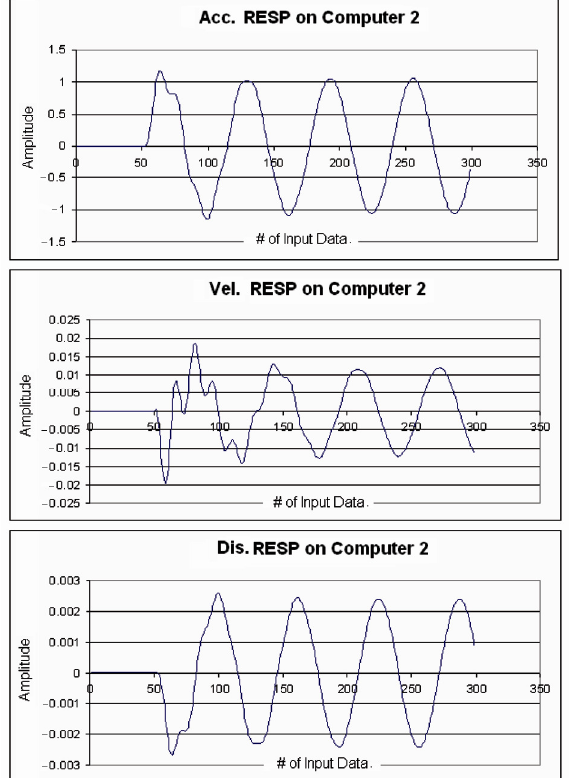
Fig. 6. Response of SDOF Structure from Computer 2